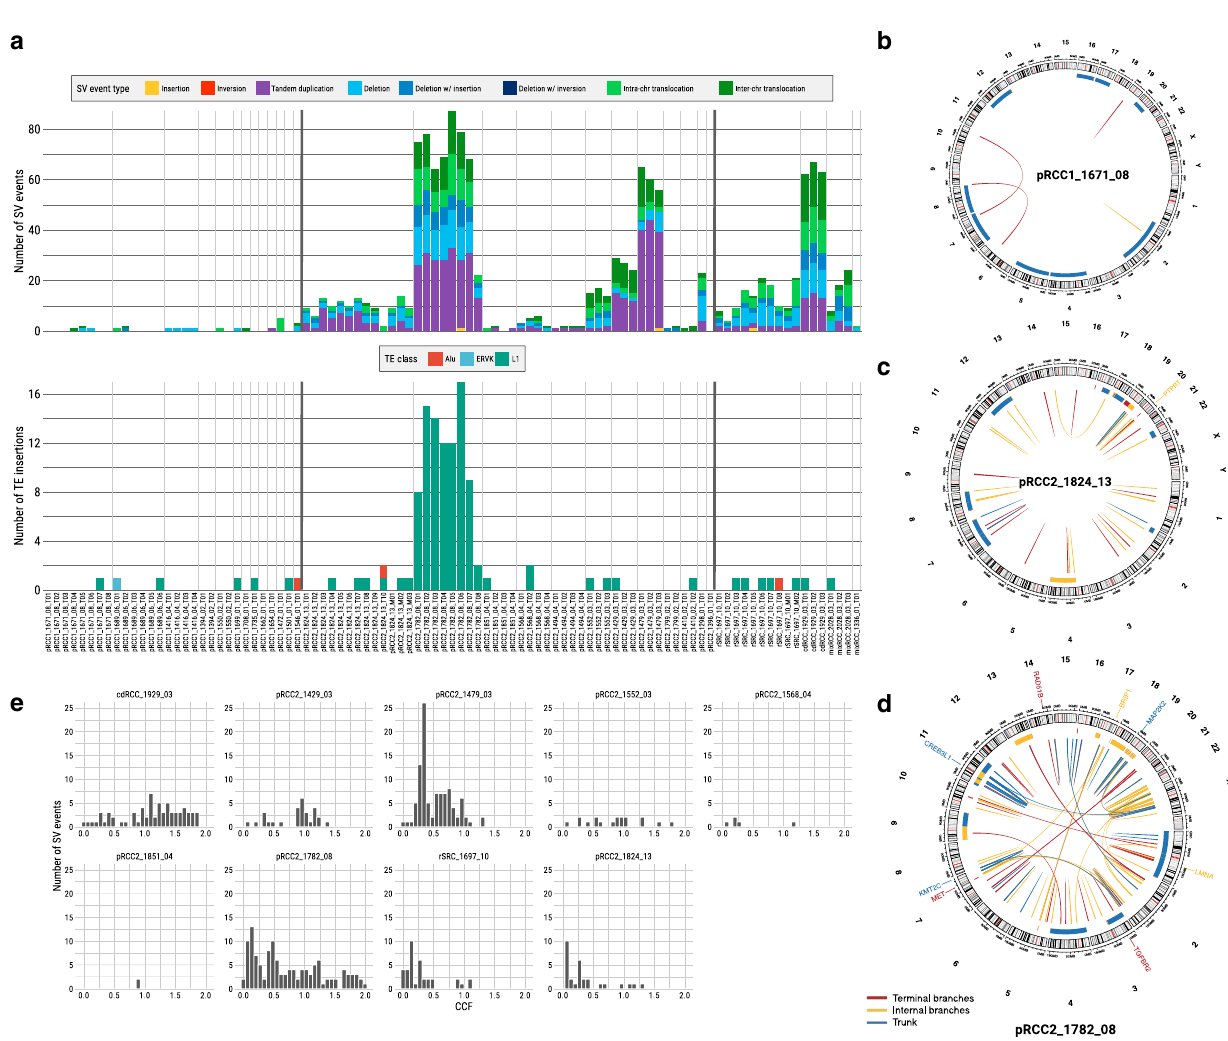
Fig. 4 Structural variants (SV) and retrotransposition events (TE). a Frequency of SV events and TE insertions for each sample. b – d Circos plots for SV events for three tumors; involved driver genes are noted. e The distribution of mean cancer cell fraction (CCF) of SVs across tumors. Alu elements originally characterized by the action of the Arthrobacter luteus (Alu) restriction endonuclease, ERVK mouse endogenous retrovirus K, L1 Long interspersed